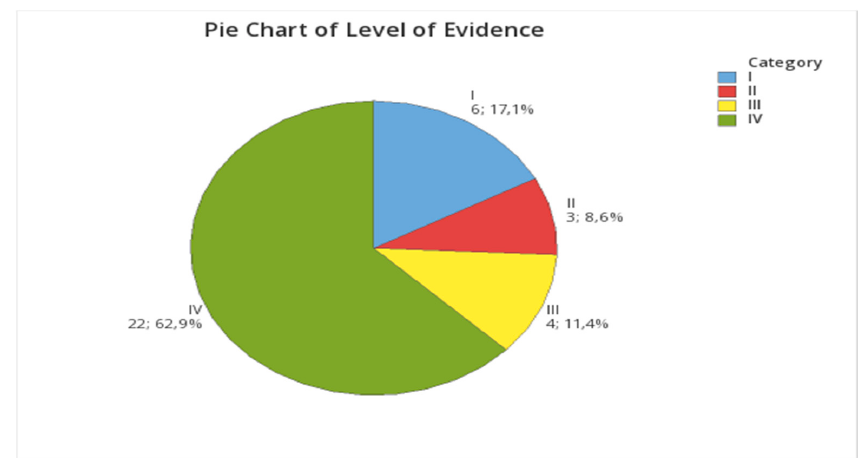
Figure 2. Pie chart of the level of evidence. I, Randomized controlled trial; II, Prospective cohort study patients compared with a control group of patients treated at the same time and institution; III, Case control study and retrospective cohort study; and IV, Case series (no control group or historical control group). Table 2. Case series (CS); Randomized Clinical Trials (RCT); Retrospective Studies (RS); Clinical Trials (non-randomized, non-controlled) (CT); Controlled Clinical Trials (CCT); and Case Reports (CR). Level of Evidence: I, randomized controlled trial; II, Prospective cohort study patients, compared with a control group of patients treated at the same time and institution; III, Case control study and retrospective cohort study; and IV, case series (no control group or historical control